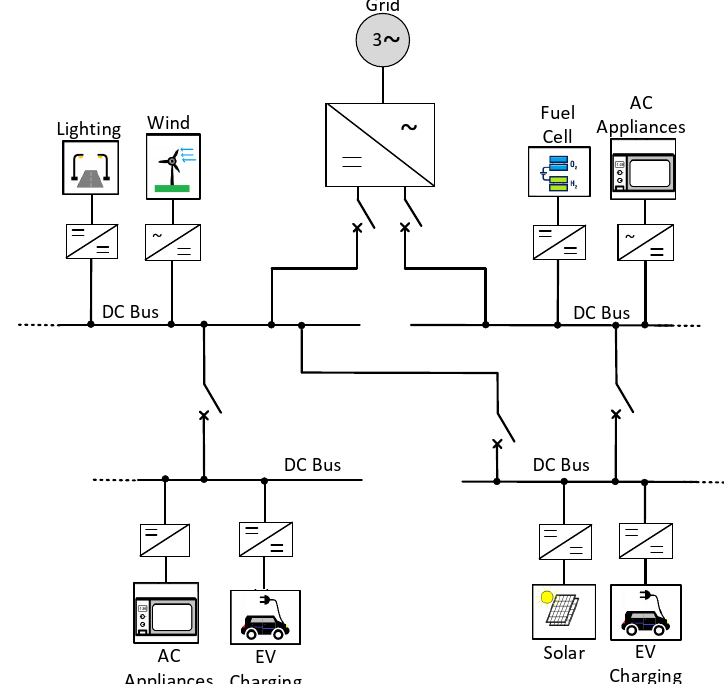
Figure 4. A schematic of typical example of the mesh topology.